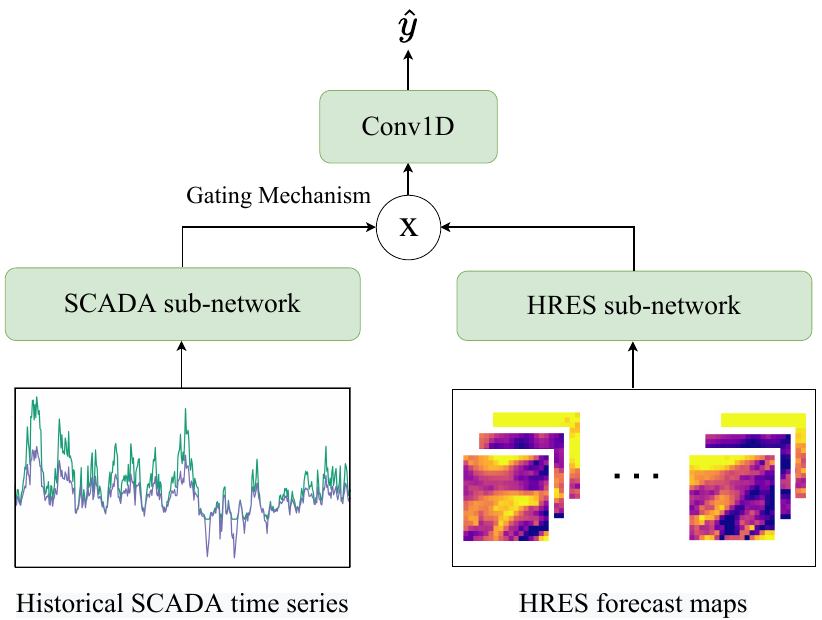
Figure 3. The complete architecture of the proposed spatio-temporal neural